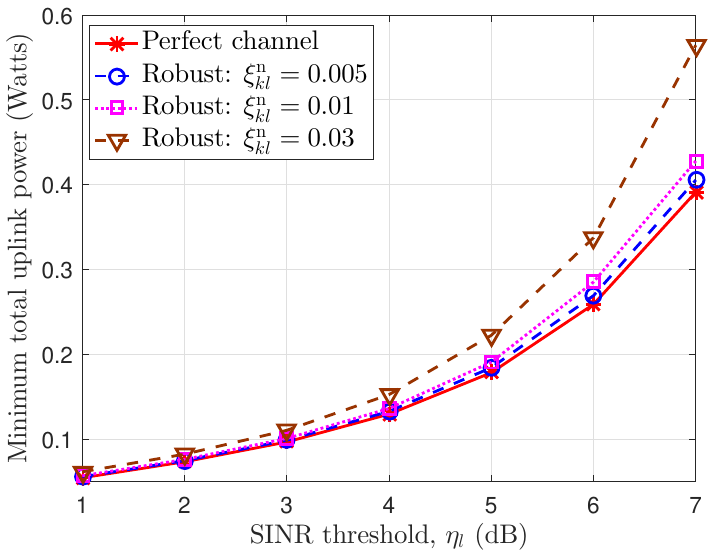
Figure 6. The minimum total uplink power according to the SINR threshold at the base